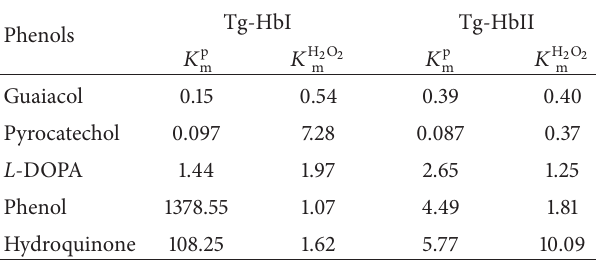
Table 1: Michaelis–Menten constants of